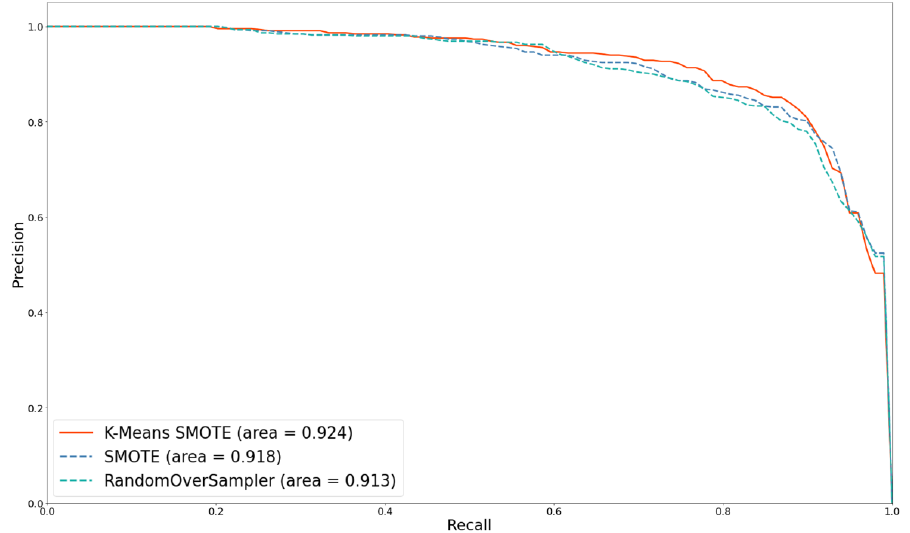
Figure 11. PR curves comparison with different oversampling techniques.